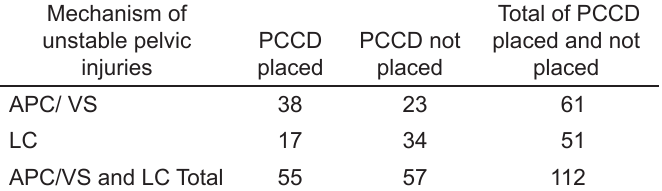
Table 1. Mechanism of injury vs binder placement.